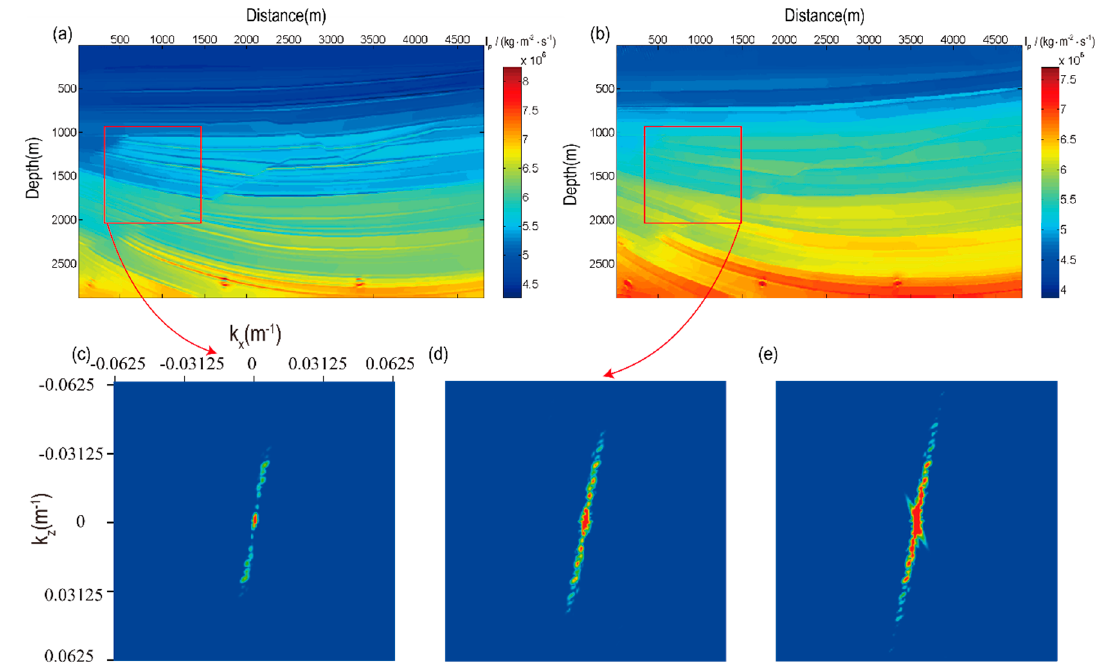
Figure 5. The inverted AI from conventional GBM ( a ) and the inverted AI from the corrected image of the new method. ( c , d ) are the spectrum of the areas marked by red rectangles in ( a , b ), respectively, and ( e ) shows the spectrum of the same position of the true AI model in Figure 1a. We can see that the inverted impedance of the proposed method has a wider spectral band than the conventional one, and it has similar spectral pattern to the true one.